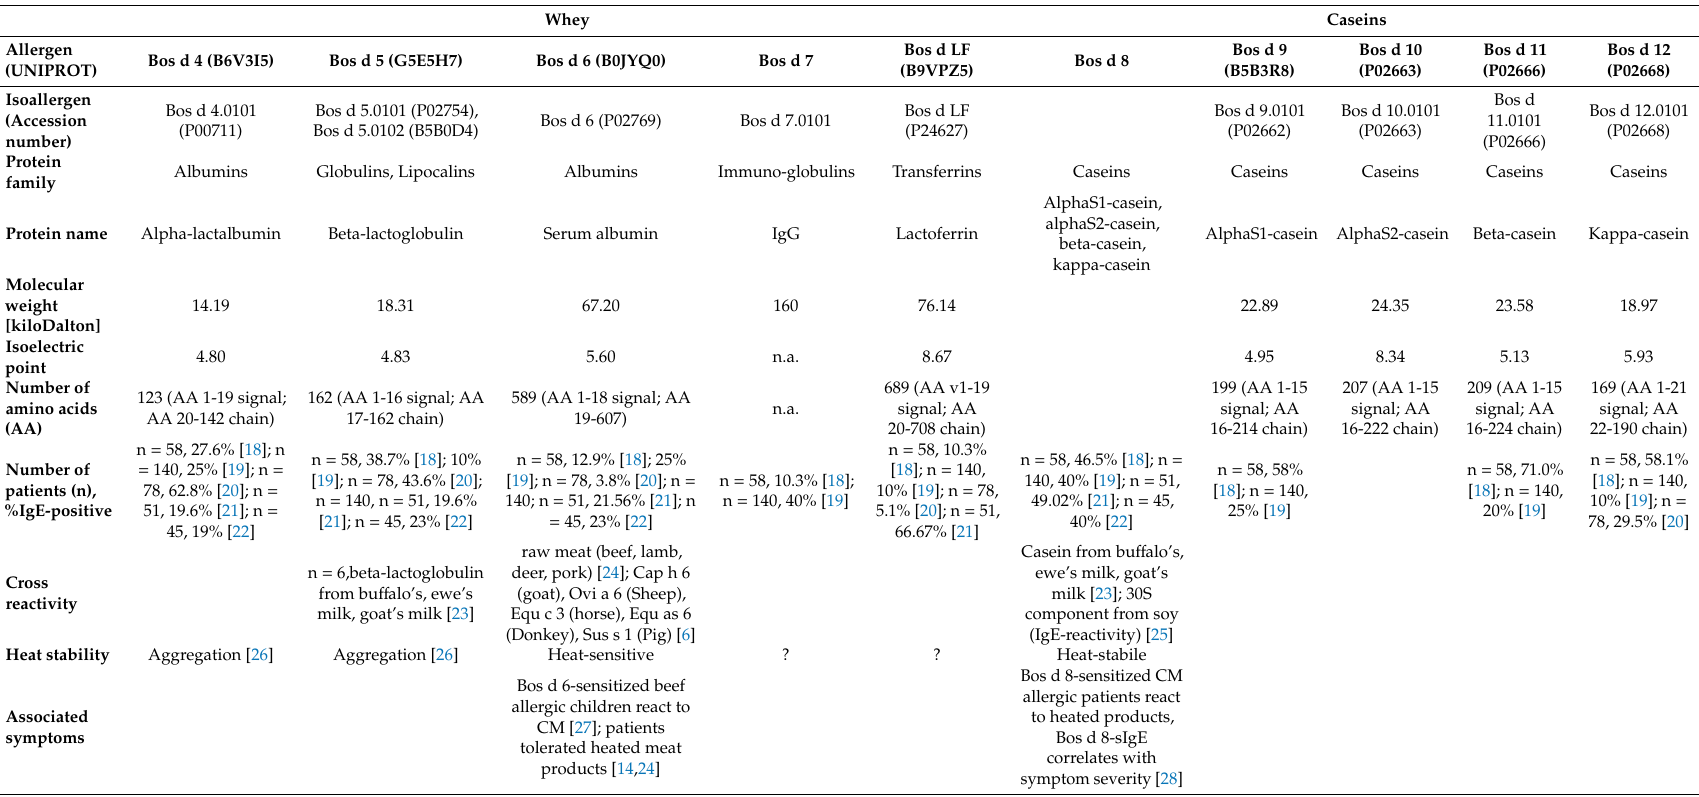
Table 1. Characteristics of cow’s milk